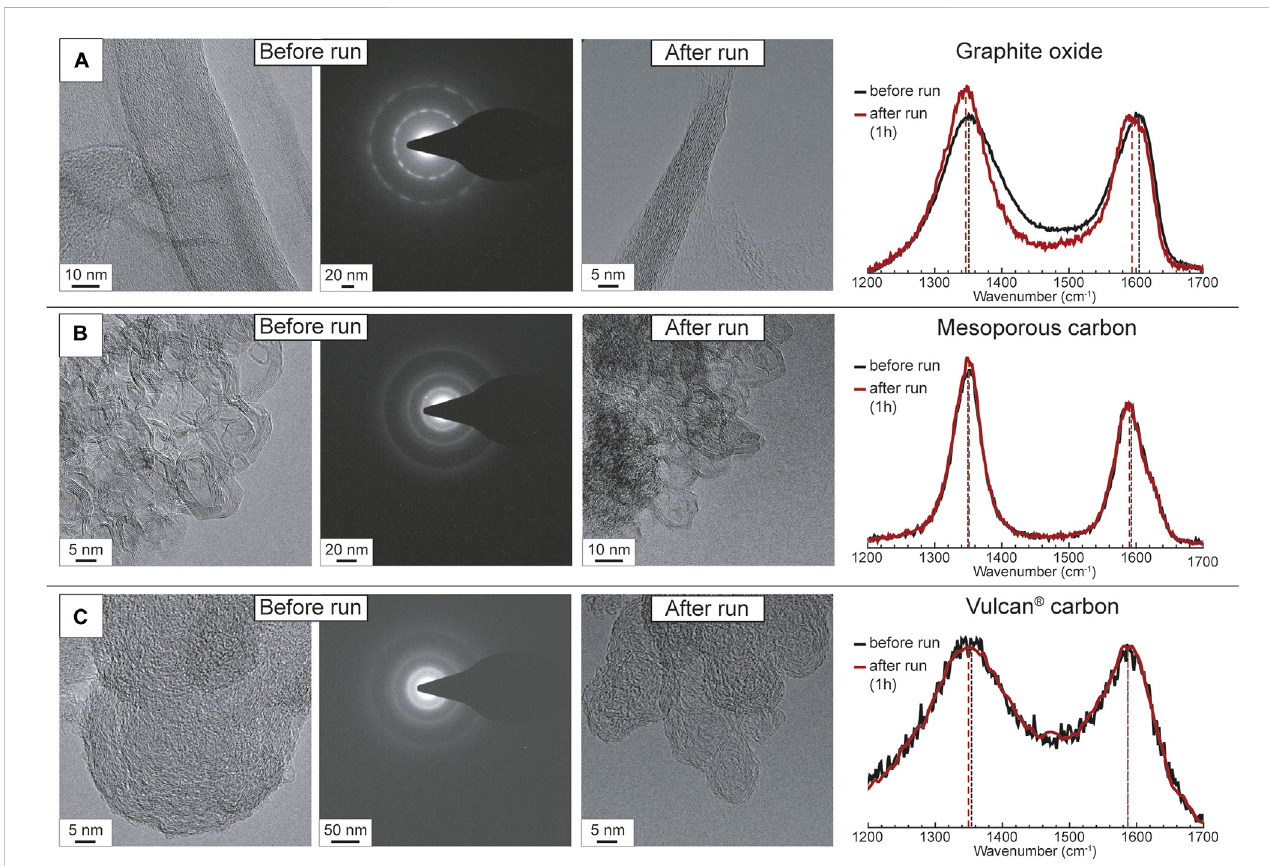
FIGURE 2 Representative TEM images and Raman spectra of (A) graphite oxide, (B) mesoporous carbon and (C) Vulcan ® carbon before and after the experimental runs. TEM images of the starting materials are coupled with SAED diffraction patterns to show their degree of structural organization. The intensities of the Raman spectra are normalized to the same